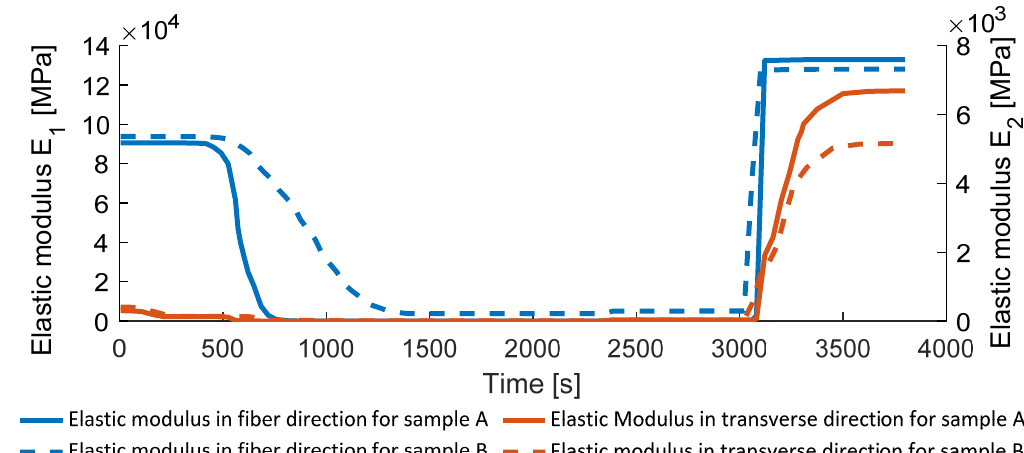
Figure 19. Elastic modulus.